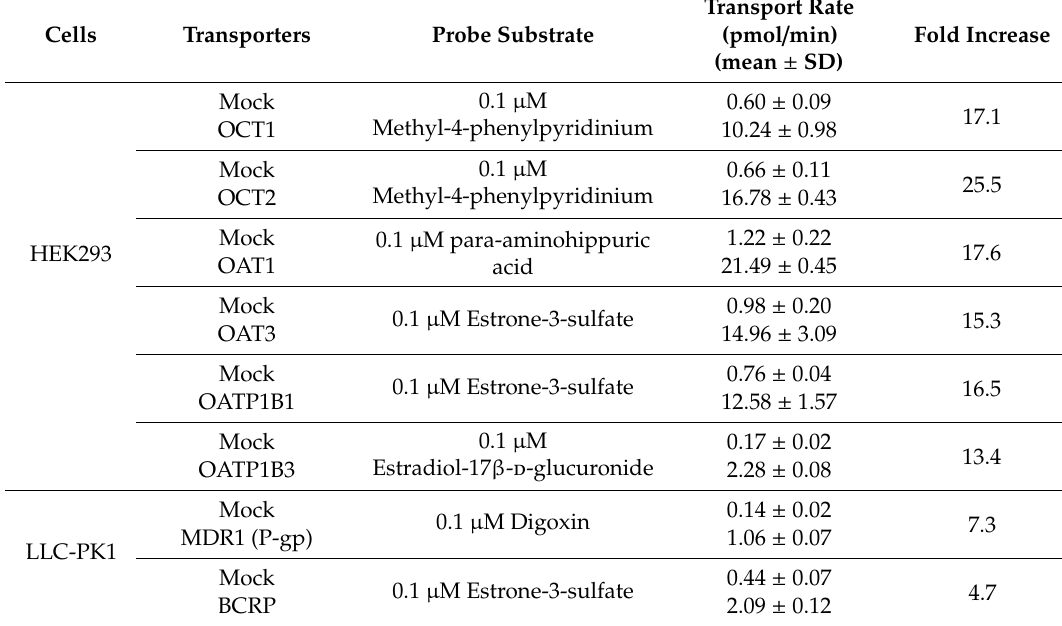
Table 2. Transport rate of the probe substrate in HEK293 cells overexpressing solute carrier transporters and LLC-PK1 cells overexpressing e ffl ux transporters ( n =